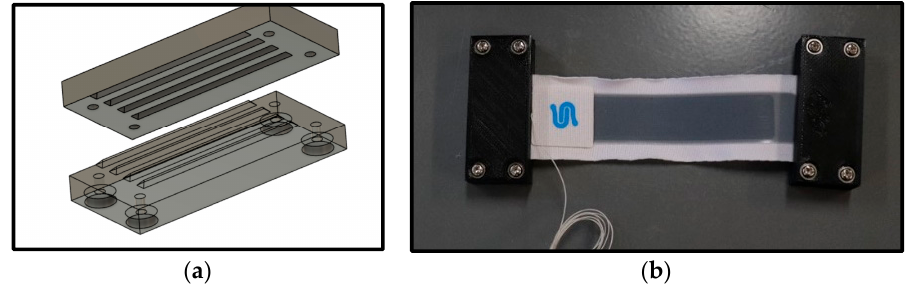
Figure 21. ( a ) CAD model version of SRS clamps, ( b ) 3D-printed SRS clamps for Instron low-cycle fatigue (LCF) and high-cycle fatigue (HCF) fatigue testing.